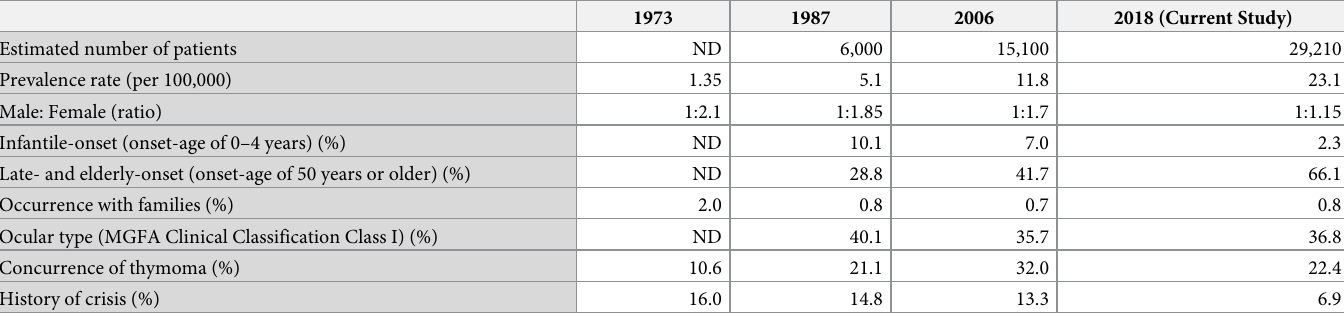
Table 2. Comparison of demographic features among nationwide surveys in